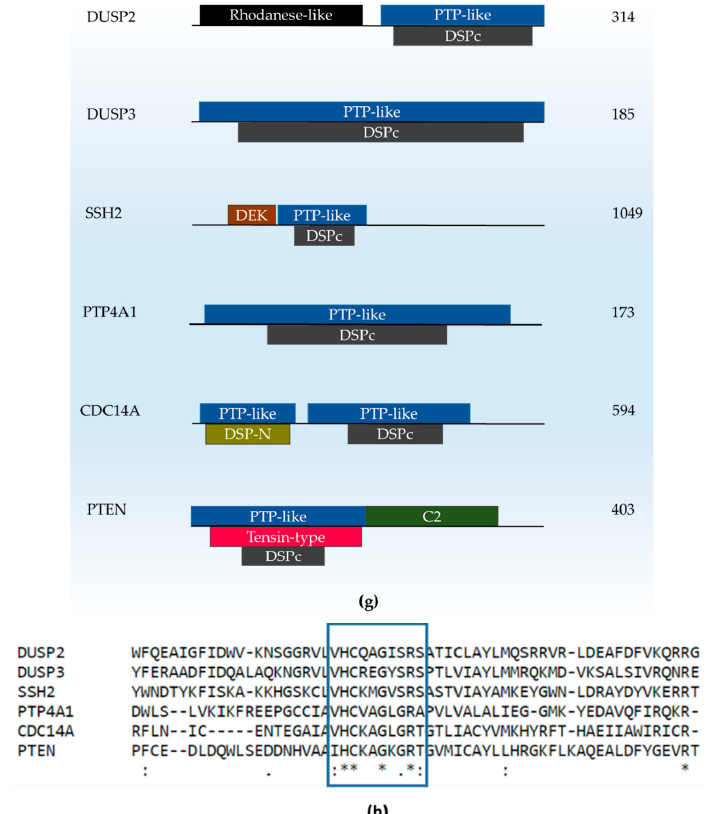
Figure 2. Structural features of typical members from each DUSP subfamily. ( a – f ) Molecular representations of typical member from each DUSP subfamily using data available from Protein Data Bank (PDB) and redrawn using Avogadro: an open-source molecular builder and visualization tool, version 1.XX, http://avogadro.cc/. Cyan color on the structure indicates helix, yellow color indicates sheet, and brown color represents loop structures; ( a ) Image of 1M3G represents DUSP2 structure [20] of the MKP subfamily; ( b ) Image of 3F81 represents DUSP3 structure [21] of the atypical-DUSP subfamily; ( c ) Image of 2NT2 represents SSH2 structure [22] of the slingshot phosphatase subfamily; ( d ) Image of 1XM2 represents PTP4A1 structure [23] of the PTP4A phosphatase subfamily; ( e ) Image of 1OHC represents CDC14A structure [24] of the CDC14 phosphatase subfamily; ( f ) Image of 1D5R represents PTEN structure [25] of the PTEN phosphatase subfamily; ( g ) Domain representation of typical member of each DUSP subfamily: DUSP2, DUSP3, SSH2, PTP4A1, CDC14A and PTEN created from data available on InterPro [26] (not drawn-to-scale). Abbreviations of domains listed in the figure include, PTP-like: Protein tyrosine phosphatase-like; DSPc: Dual-specificity phosphatase, catalytic; DSP-N: Dual-specificity phosphatase, N-terminal. Numbers on the right side indicate amino acid length. It should be noted that variations exist in individual members from each subfamily in presence/absence of protein domains and taken into consideration. For further information on protein domains of an individual DUSP, please refer to Table 1 and [27]; ( h ) Multiple sequence alignment of typical members of each DUSP subfamily: DUSP2, DUSP3, SSH2, PTP4A1, CDC14A and PTEN. Amino acid sequences were obtained from UniProt [28], and aligned using Clustal Omega at EMBL-EBI [29,30]. Blue box indicates the conserved catalytic DUSP motif (V)-HC-XX-X-XX-R-(S/T), where X represents any amino acid; (:) indicates conservation between groups of strongly similar properties; (*) indicates a conserved residue; (.) indicates conservation between groups of weakly similar properties.